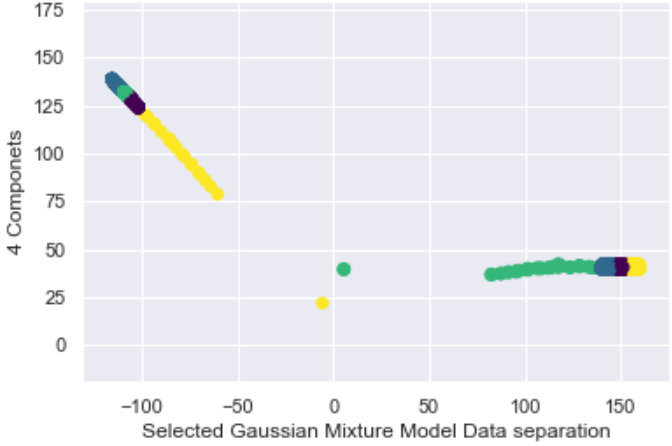
Figure 21. Data separation by